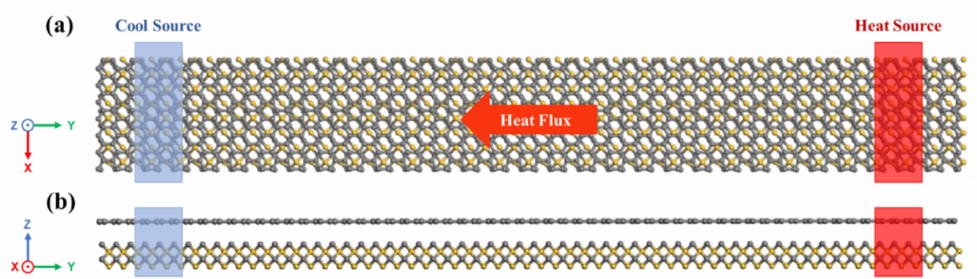
Figure 2. A typical schematic illustration of the NEMD simulation setup. Top ( a ) and side ( b ) views of GS-Hs. Heat flows from the heat source to the cool source, as indicated by the arrow pointing towards the cool